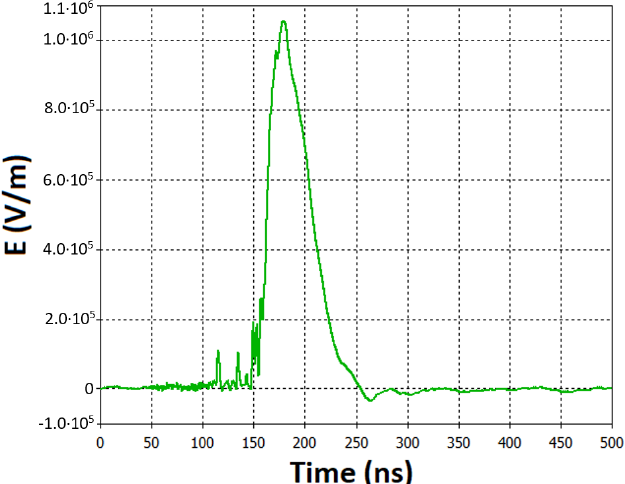
Figure 11. Changes in time of the electrical component of an electromagnetic pulse (data obtained from the Teledyne LeCroy (640 Zi) oscilloscope). Data was used for the calculations in CST ® STUDIO SUITE ® 2021.05 software.